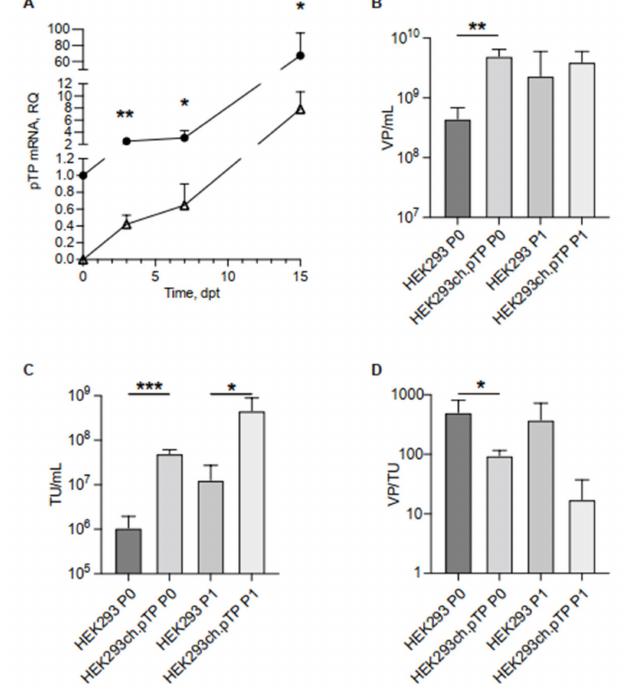
Figure 2. Transcript of ch.pTP and chAd-C vector produced in HEK293ch.pTP and HEK293 cells. ( A ) Real Time PCR analysis of ch.pTP transcript produced during the packaging of a chAd-C vector at P0 in HEK293ch.pTP cells (full circle) compared to HEK293 cells (empty triangle). The amount of ch.pTP mRNA was analysed from 3 dpt up to full cytopathic effect (15 dpt) in three independent experiments. ( B ) VP/mL and ( C ) TU/mL titration of chAd-C Venus vector rescued (P0) and propagated (P1) in HEK293 ( n = 3) and in HEK293ch.pTP cells ( n = 4). ( D ) Ratio VP/TU as a parameter of the quality of chAd-C vector rescued (P0) and propagated (P1) in HEK293 and HEK293ch.pTP cells. The data are reported as mean ± SD. *** p < 0.001; ** p ≤ 0.01; * p <